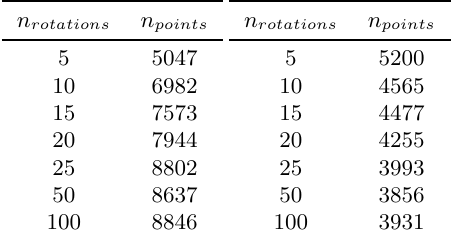
Table 2. Amount of points n captured at each step when flying the autonomous segment inspection with a r flight of 2 m ( 1 m Table 1. Column 2: Amount of points captured when flying a distance to the object surface) with ω = 0 . 25 rad/s helix with a radius of 2 m ( 1 m distance to the object surface) with ω = 0 . 25 rad/s . Column 4: Amount of points captured when flying a helix with a radius of 3 m ( 2 m distance to the object surface) with ω = 0 . 25 rad/s .